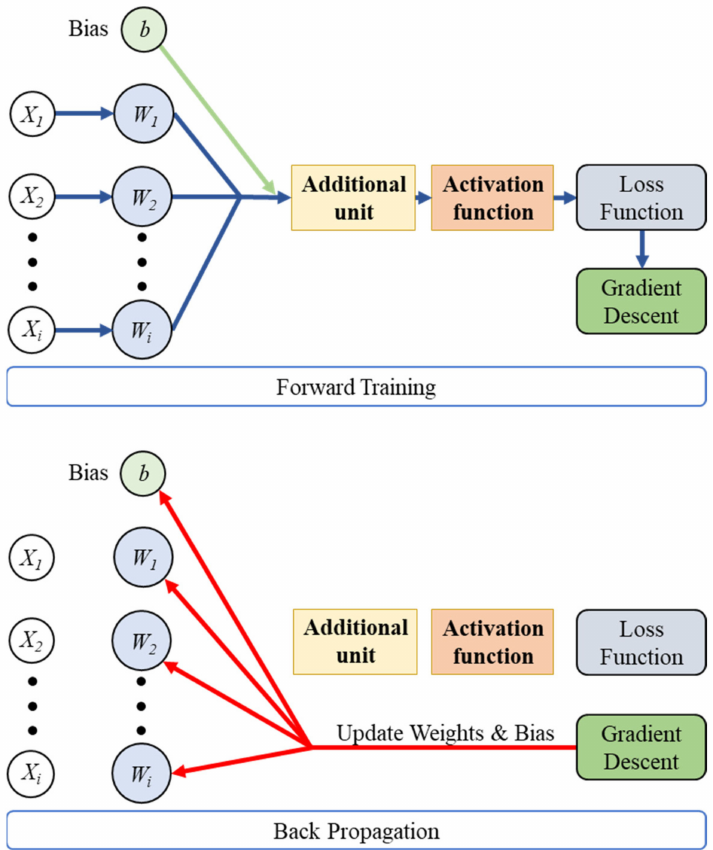
Figure 2. Basic architecture of a backpropagated neural network